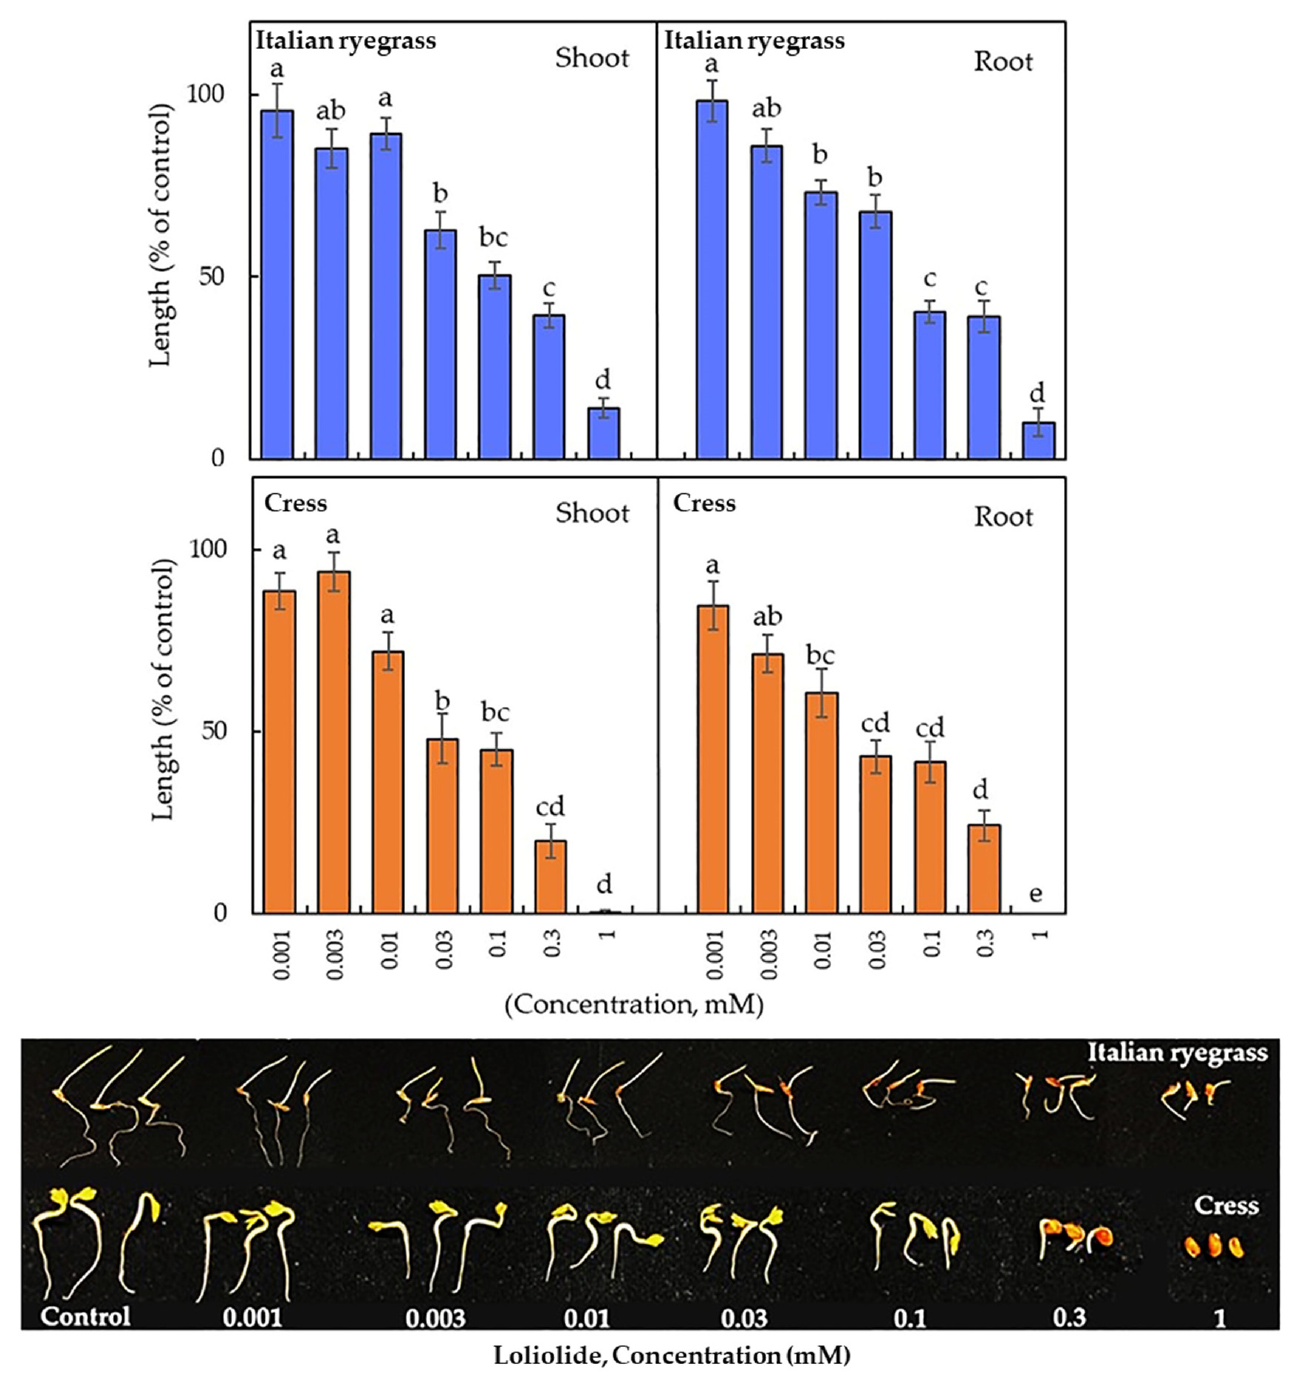
Figure 6. Effect of loliolide isolated from the Dregea volubilis leaf extracts on the seedling growth of Italian ryegrass and cress. The bars on each experiment express the mean ± SE with three replicates ( n = 30). The different letters indicate the significant differences among the treatments (Tukey’s HSD, p < 0.05). Table 1. The concentration required for 50% inhibition ( I 50 ) of the shoots and roots of Italian ryegrass and cress by the Dregea volubilis leaf extracts and its related compounds (dehydrovomifoliol and loliolide), and their respective correlation coefficient values.